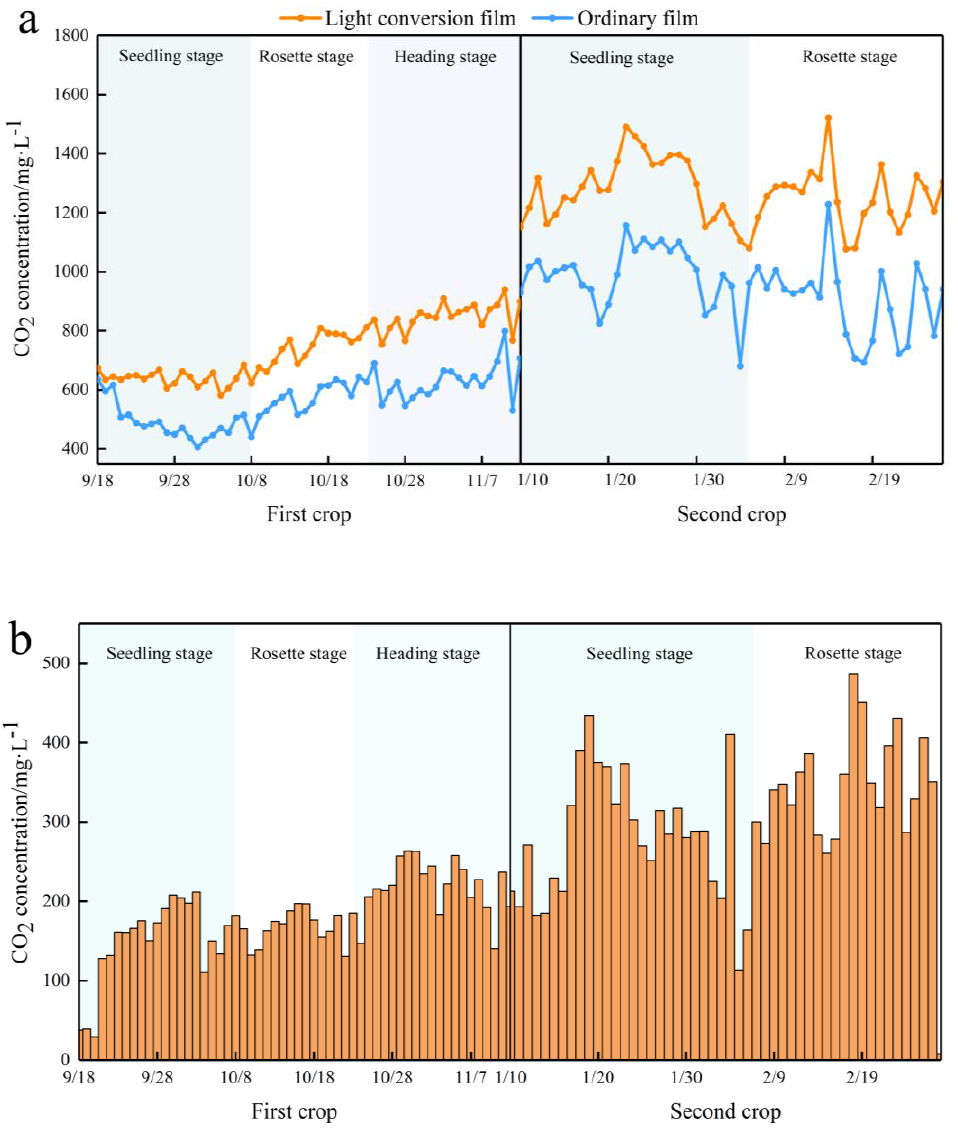
Figure 6. Effects of light conversion film (LCF) and ordinary film (OF) on CO 2 concentration in greenhouse under different crops. ( a ) Indicates the daily average CO 2 concentration change in the greenhouse environment under light conversion film and ordinary film. ( b ) Variable representing the difference between daily average CO 2 concentration of light conversion films and ordinary films.